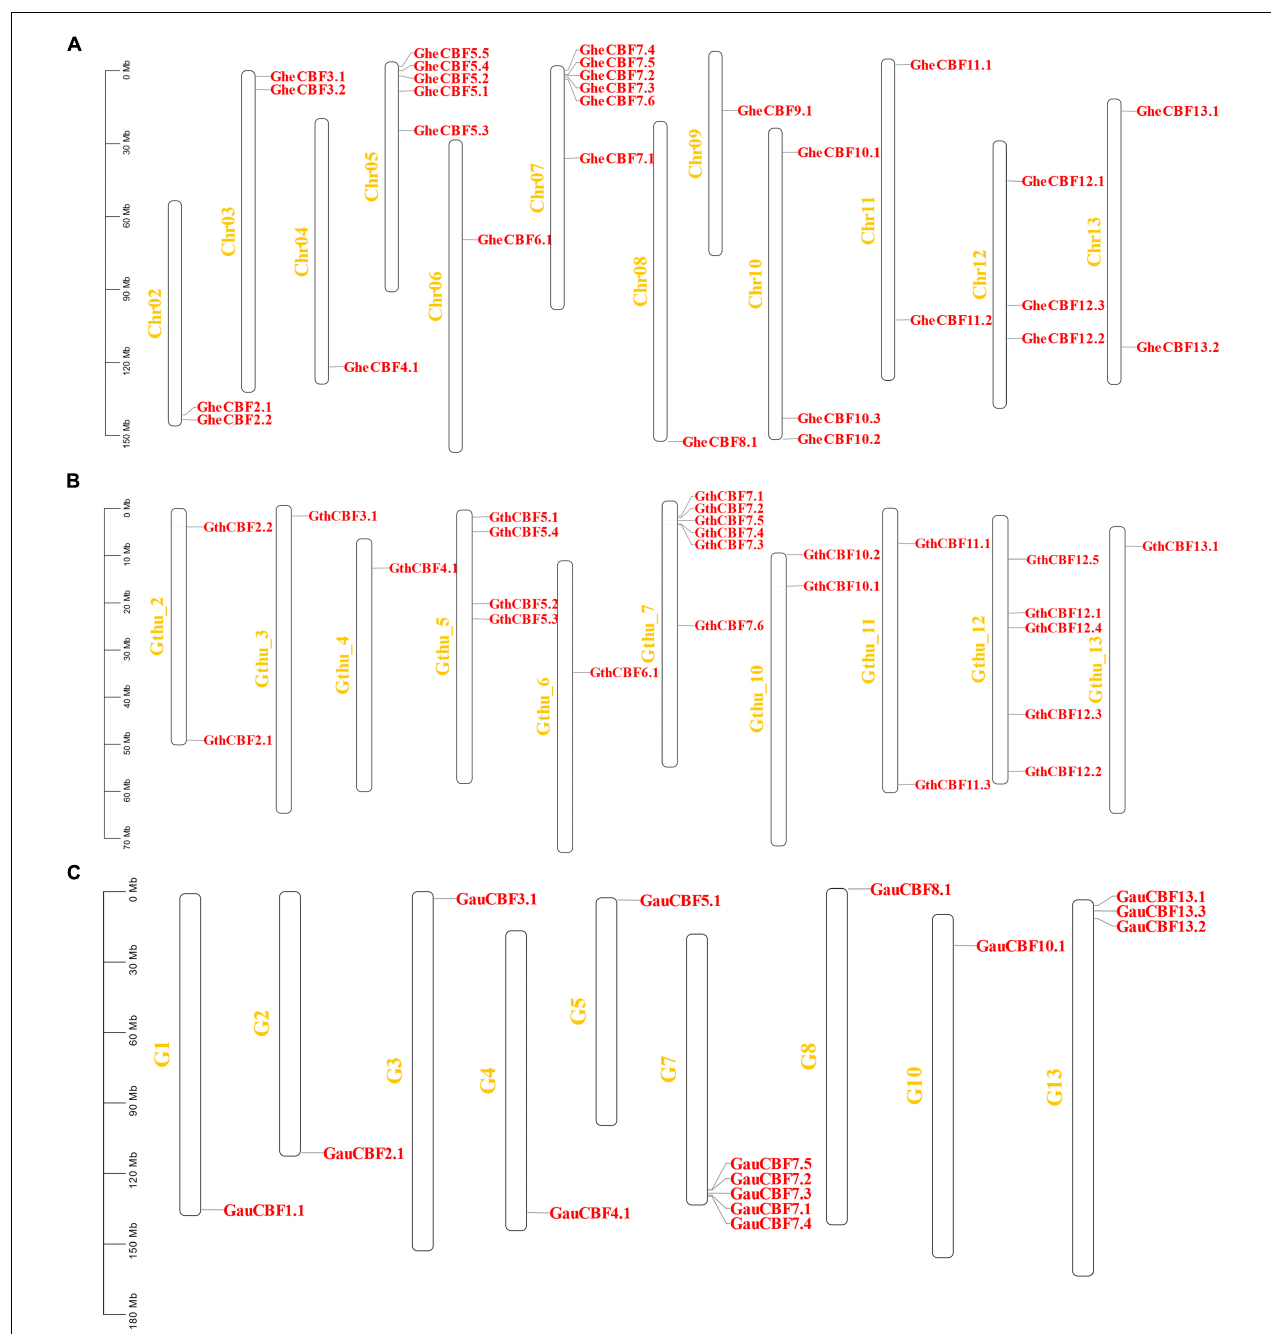
FIGURE 2 | Chromosomal positions of the CBF genes. (A) Chromosomes of G. herbaceum , (B) chromosomes of G. thurberi , and (C) chromosomes of G. australe